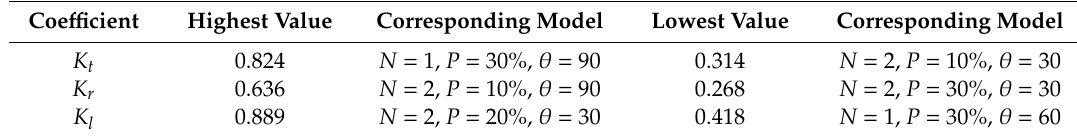
Table 3. Highest and lowest resultant hydrodynamic coe ffi